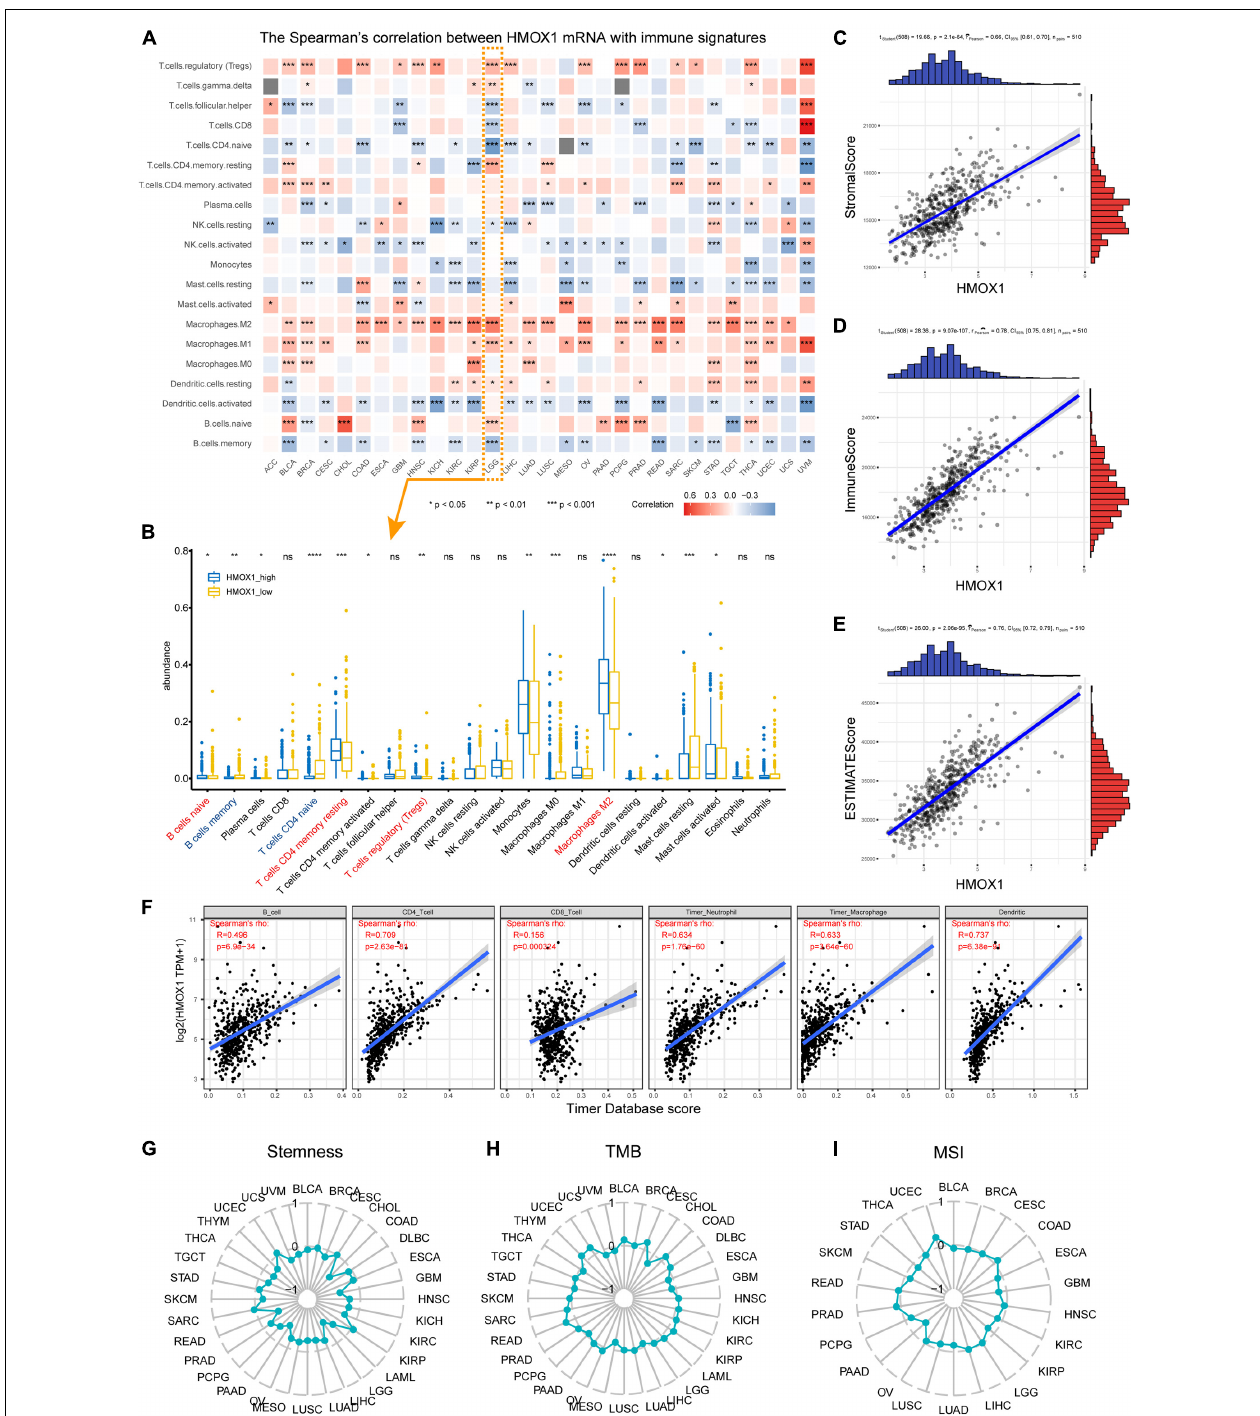
FIGURE 3 | Immune infiltration profiles of HMOX1 . (A) Correlations between HMOX1 expression and immune infiltrates in pan-cancers. (B) The abundance of immune infiltrates between HMOX1 high and HMOX1 low groups in LGG cohort based on CIBERSORT algorithm. (C–E) Correlations between HMOX1 expression and stromal, immune, ESTIMATE scores. (F) The correlations between HMOX1 expression and immune infiltrates in LGG cohort based on TIMER algorithm. (G–I) Correlations between HMOX1 expression and stemness indexes, TMB, MSI in pan-cancers. * p < 0.05, ** p < 0.01, *** p < 0.001. TMB, tumor mutation burden; MSI, microsatellite